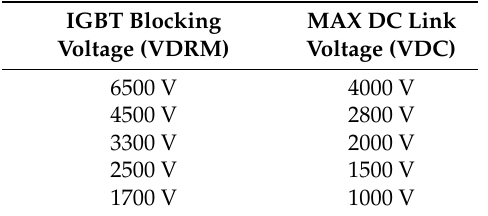
Table 3. Maximum permissible DC link voltage against blocking voltage capability of commercially available HV IGBTs.